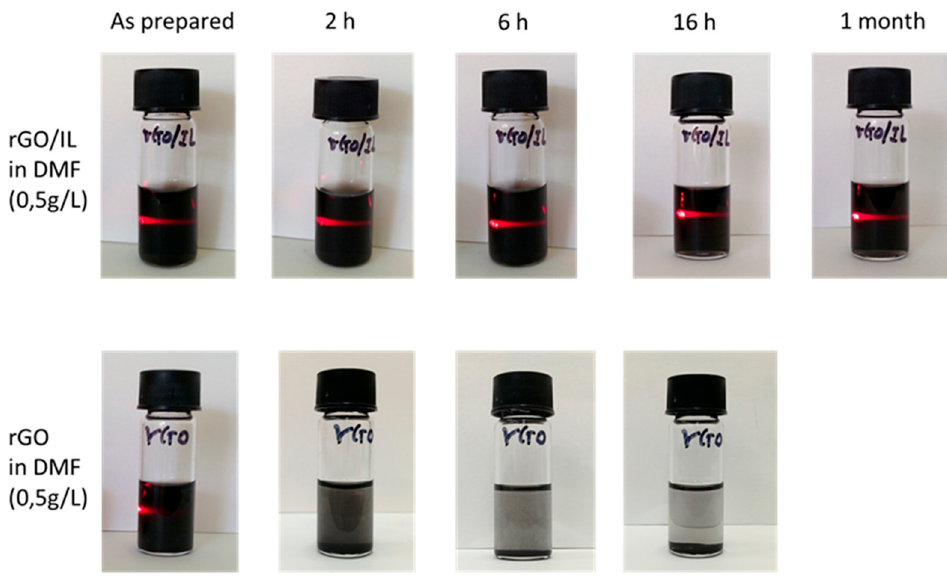
Figure 7. Dispersibility of GO in water and DMF (0.5 g/L at RT).